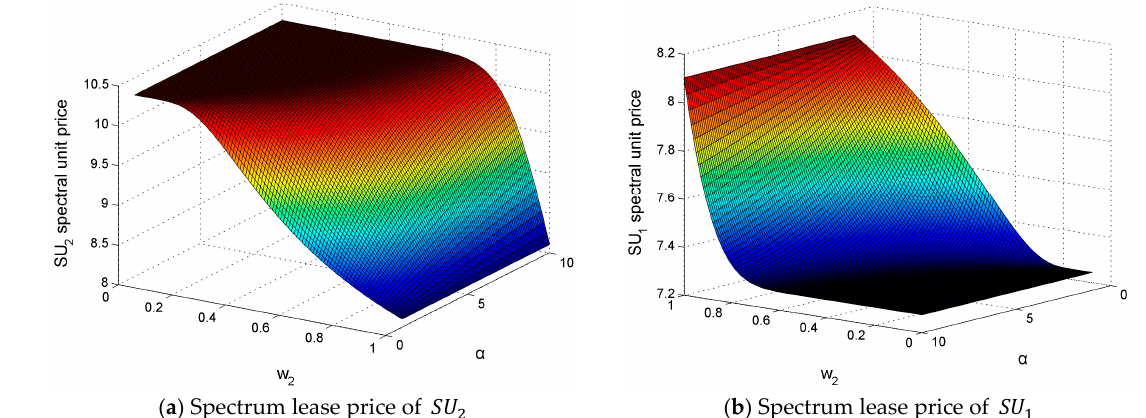
Figure 6. (cid:1845)(cid:1847) (cid:2869) and (cid:1845)(cid:1847) (cid:2870) price function with different detection capabilities and different evaluation criteria. Figure 6. SU 1 and SU 2 price function with different detection capabilities and different evaluation